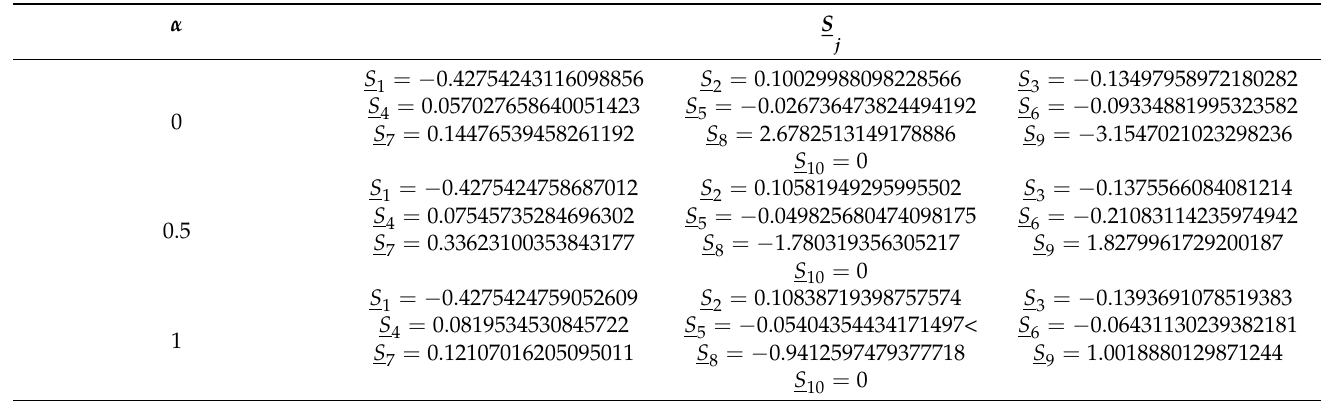
Table 3. Lower auxiliary convergence parameters of the tenth-order FF-OHAM for solving Equation (47) at ω = 1.9, x = 0.1, for all α ∈ [ 0,1 ] .